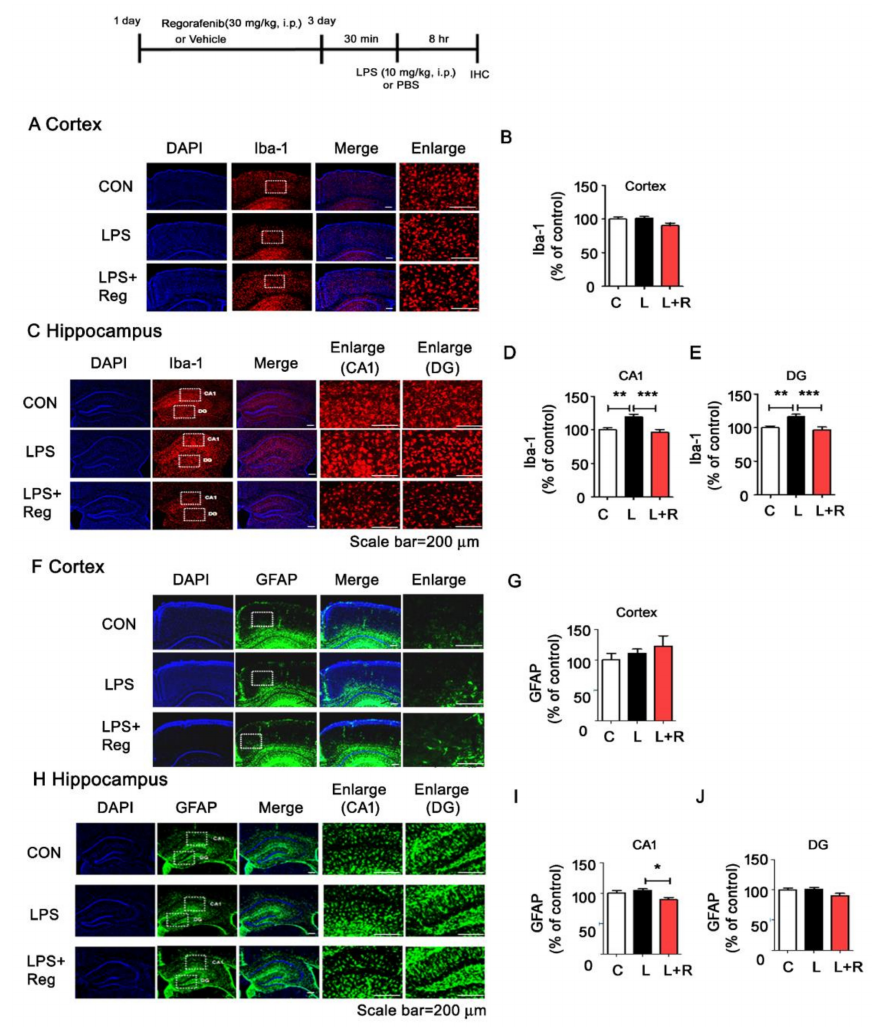
Figure 4. Regorafenib modulates LPS-induced microglial and astrocyte activation as well as proinflammatory cytokine upregulation in vivo. ( A – E ) Wild-type mice were injected with regorafenib (30 mg / kg, i.p.) or vehicle (2% DMSO + 30 % PEG + 5 % Tween 80) daily for three days and subsequently treated with LPS (10 mg / kg, i.p.) or PBS for 8 h. Then, the treated wild-type mice were perfused and fixed, and immunohistochemistry was performed with anti-Iba-1( A – E ) or anti-GFAP ( F – J ) antibodies in the cortex and hippocampus (n = 7 mice / group). * p < 0.05, ** p < 0.01, *** p <